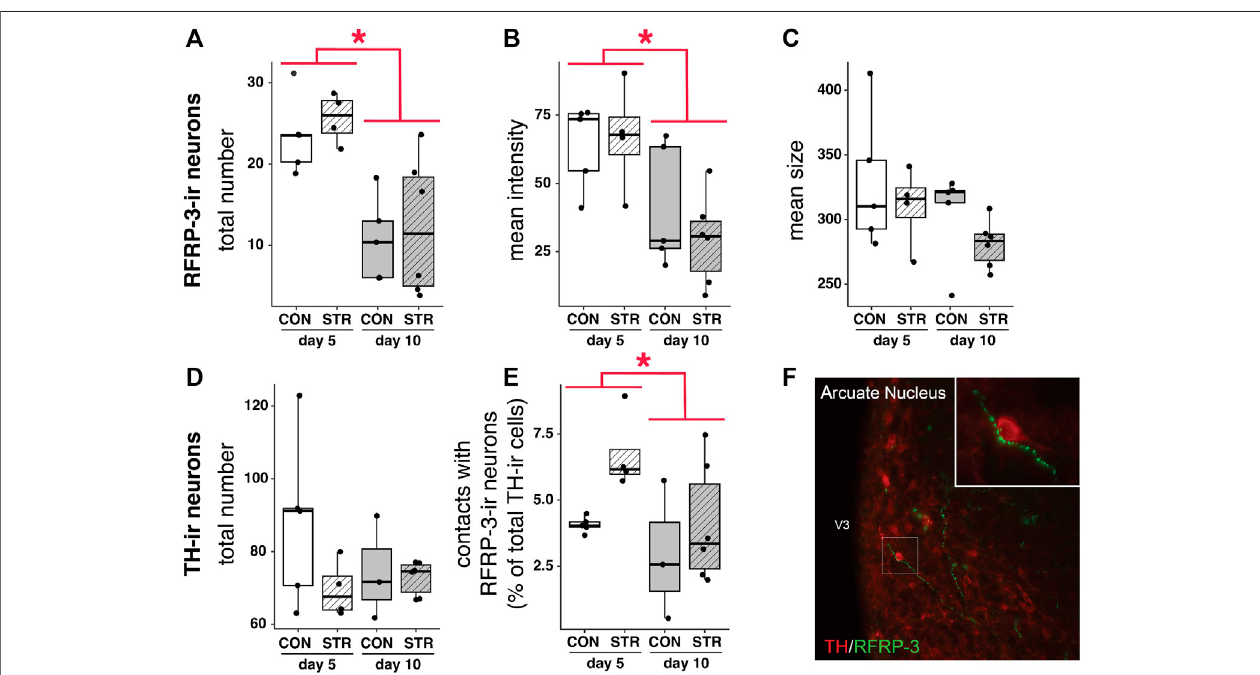
FIGURE 2 | RFRP-3-ir cell numbers/intensity and projections to TIDA (TH+) neurons are impacted by stage of pregnancy, but not by stress. (A – C) Number and intensity of RFRP-3-ir neurons were modulated by pregnancy progression but unaffected by stress, whereas the size of RFRP-3-ir neurons remained constant in all treatments. (D,E) The number of TH + cells was unaltered by gestational day of pregnancy or stress exposure, whereas contacts between TH + cells and RFRP-3-ir neuronsdecreasedacrossgestation. (F) ArepresentativeimageofTH+neuronreceivingclosecontactsfromRFRP-3-iraxon.Highpowerinsetshowscontactsin further detail. Asterisks (*) indicate signi fi cant ( p < 0.05) main